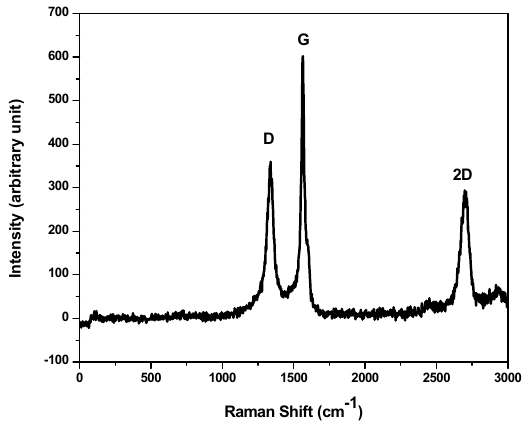
Figure 3. Raman spectrum of sample H2 showing presence of increased D peak and decreased 2D peak due to more N-doping.